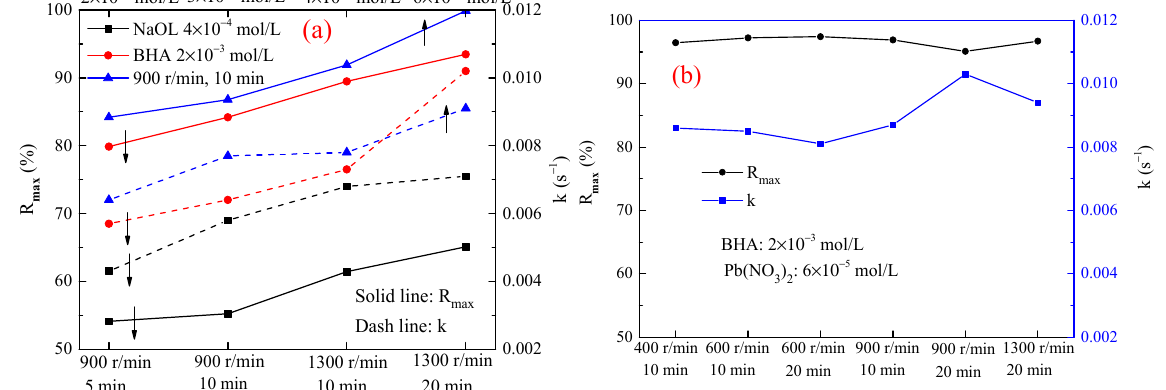
Figure 10. Fitting results of scheelite flotation rate experiments in the presence of NaOL and BHA under different stirring conditions and different BHA concentrations after stirring at 900 r/min for 10 min ( a ) and in the presence of Pb 2+ + BHA under different stirring conditions ( b ).